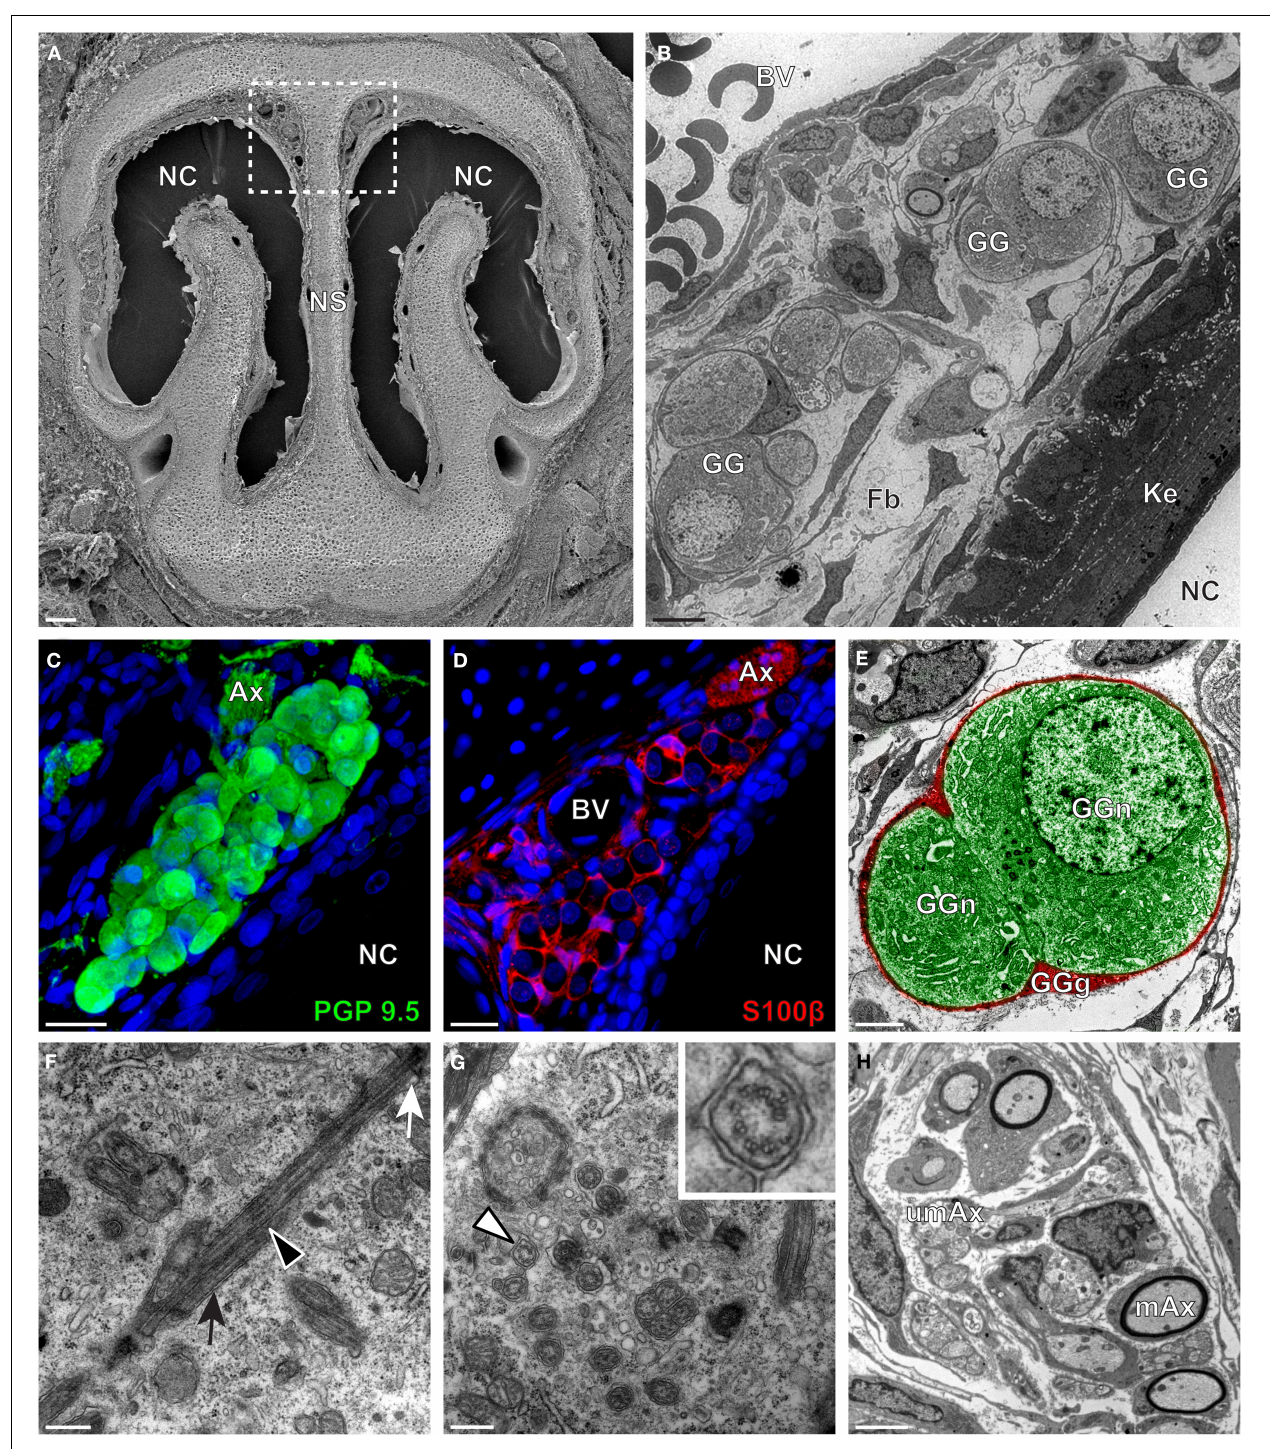
FIGURE 2 | Morphology and ultrastructural features of rat GG. (A) General SEM view of a coronal slice performed in a rat (P7) GG region. The nasal septum (NS) and the nasal cavities (NC) are shown. The white dashed rectangle highlights the GG region. (B) TEM observation of a group of rat (P7) GG cells. The presence of a meshwork of fibroblasts (Fb) and a keratinized epithelium (Ke) separating the GG neurons from